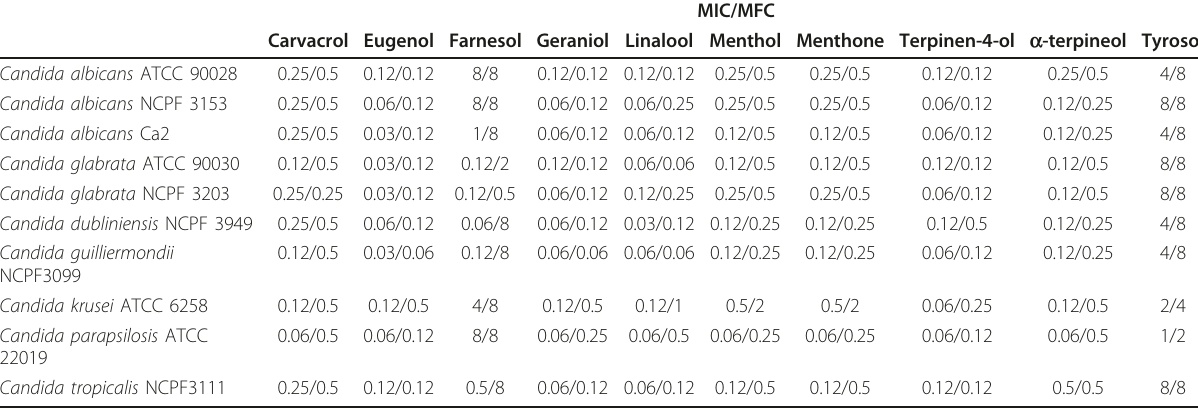
Table 1 In vitro antifungal activity of the ten natural compounds against reference strains at 24 h (%,